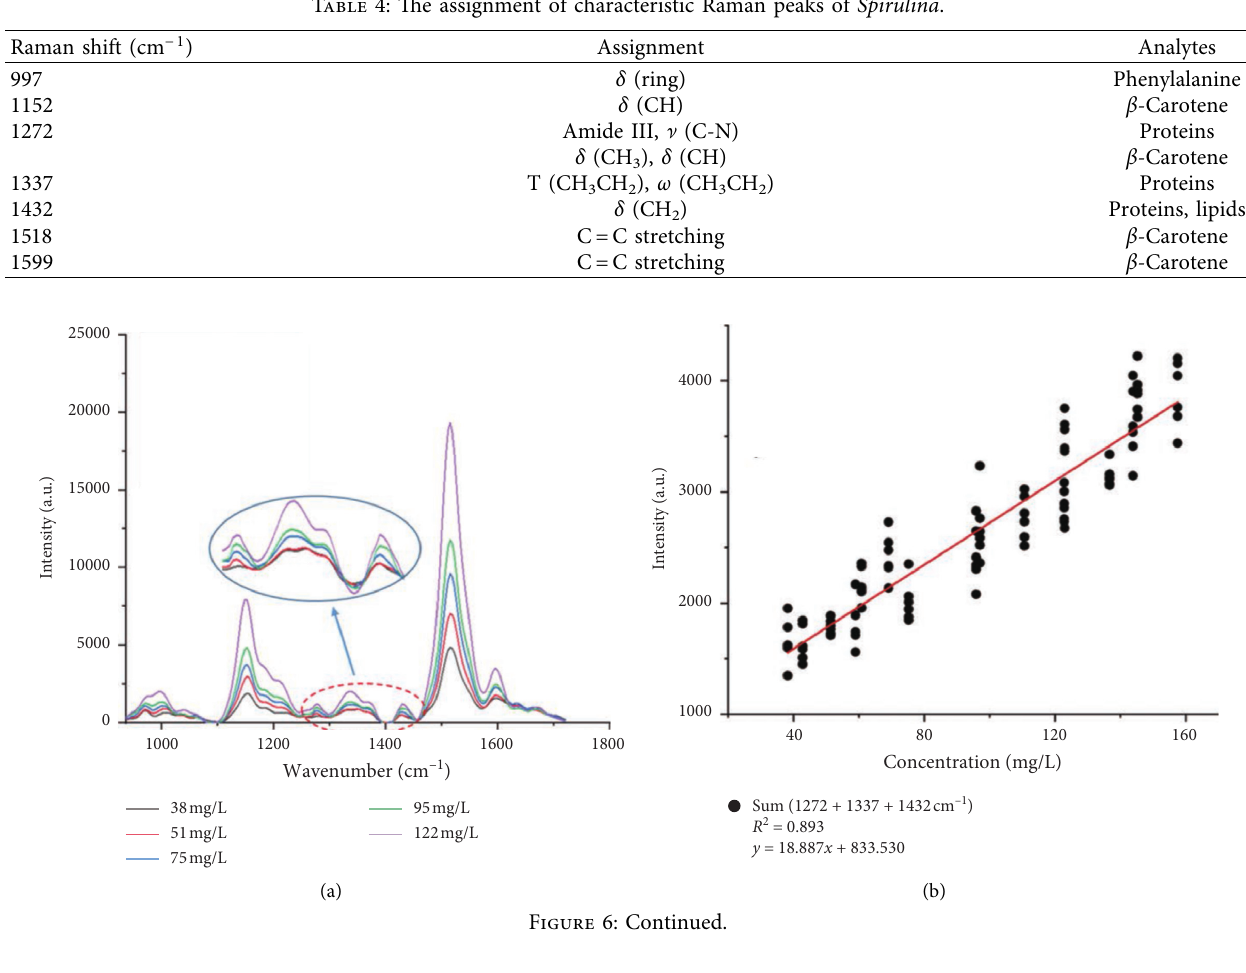
Figure 5: (a) Spectrum of Spirulina fluid after processing; (b) comparison of the theory calculation of phycocyanin by density functional theory and the spectrum of Spirulina fluid detected by Raman spectrometer Table 4: The assignment of characteristic Raman peaks of Spirulina .